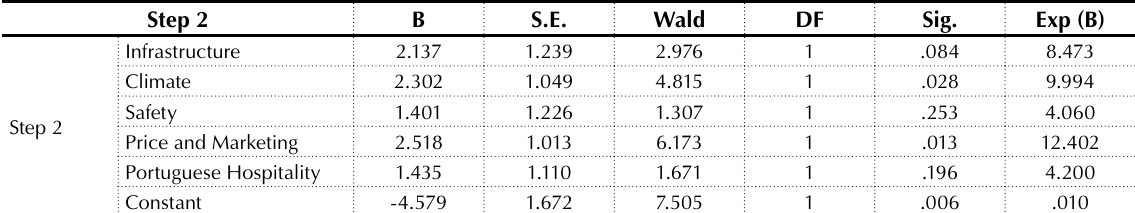
Table 2. Unrestricted model estimation